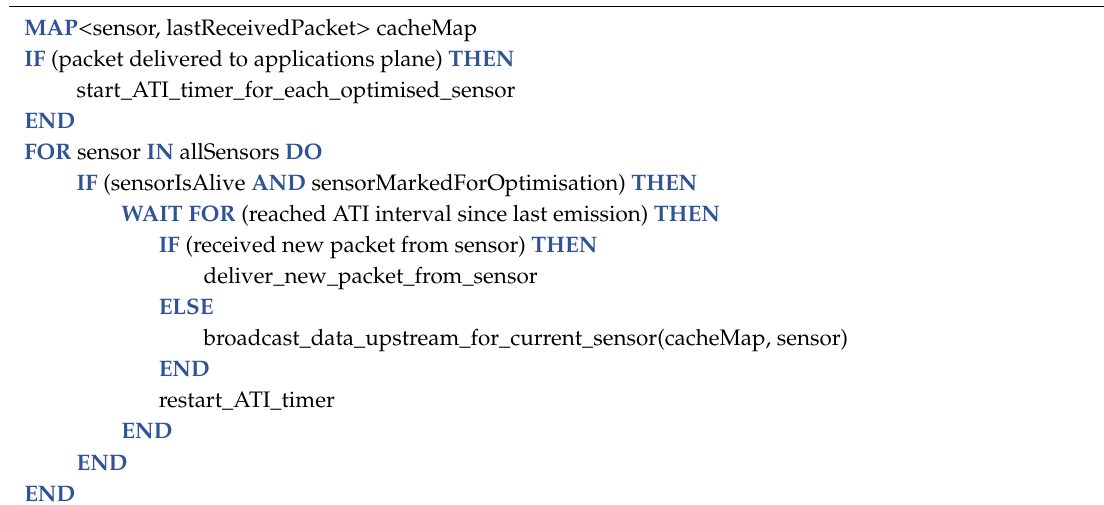
Procedure 4. Adaptive data broadcast